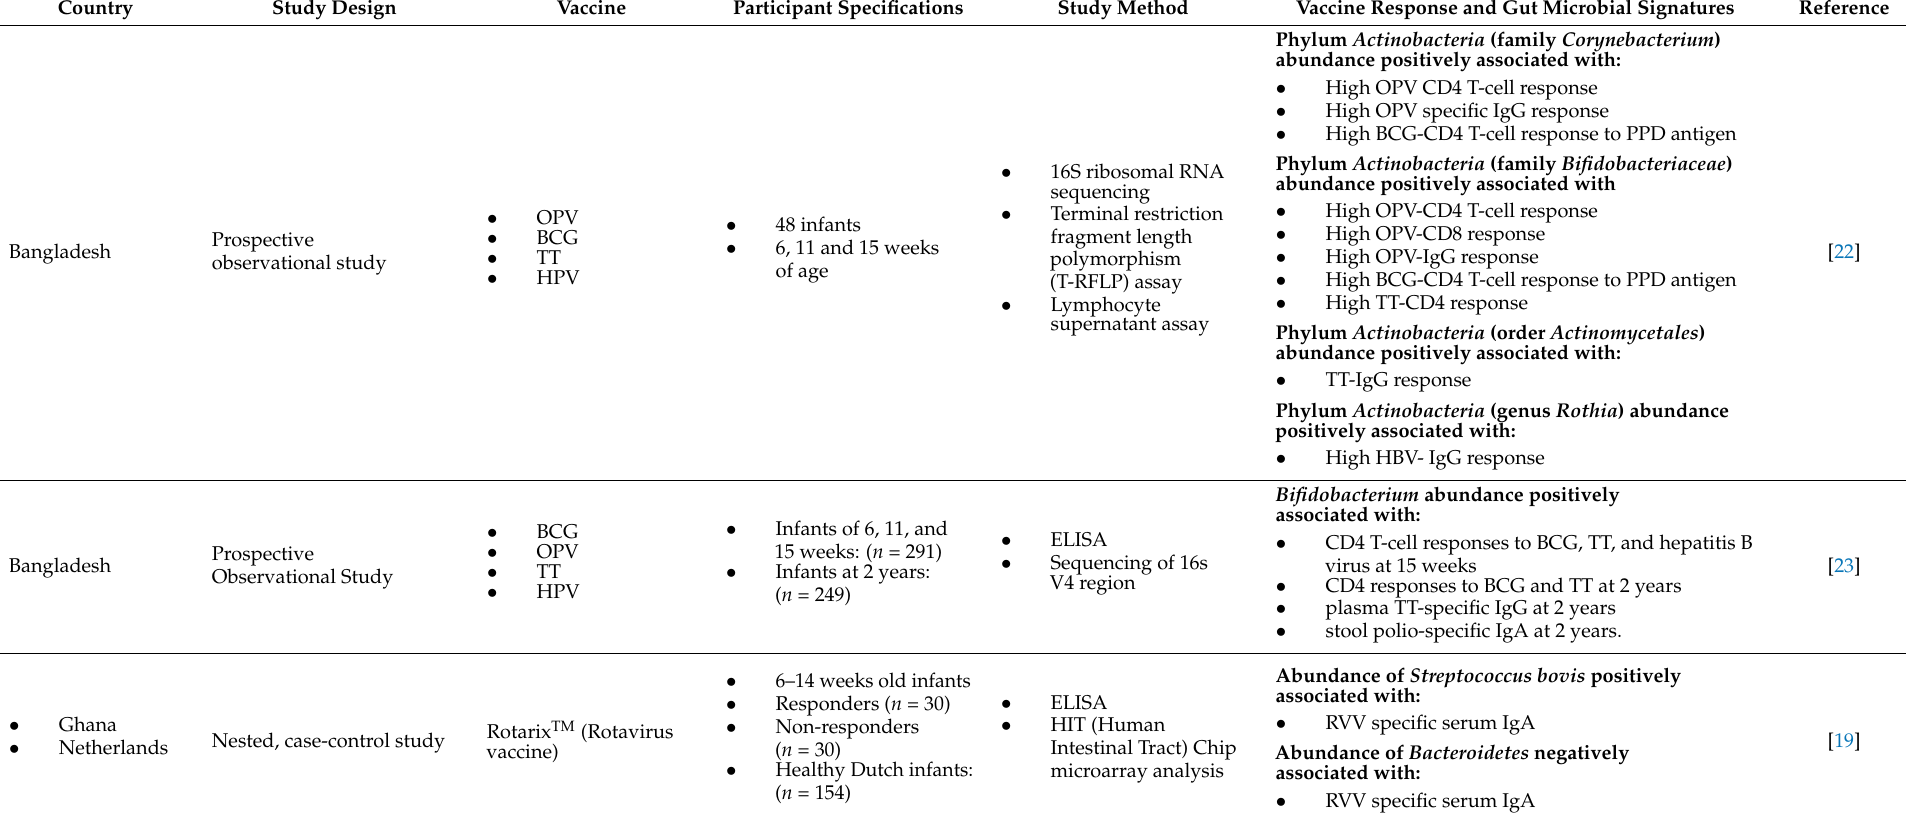
Table 1. Evidence of the influence of the Gut Microbiome on vaccine response in